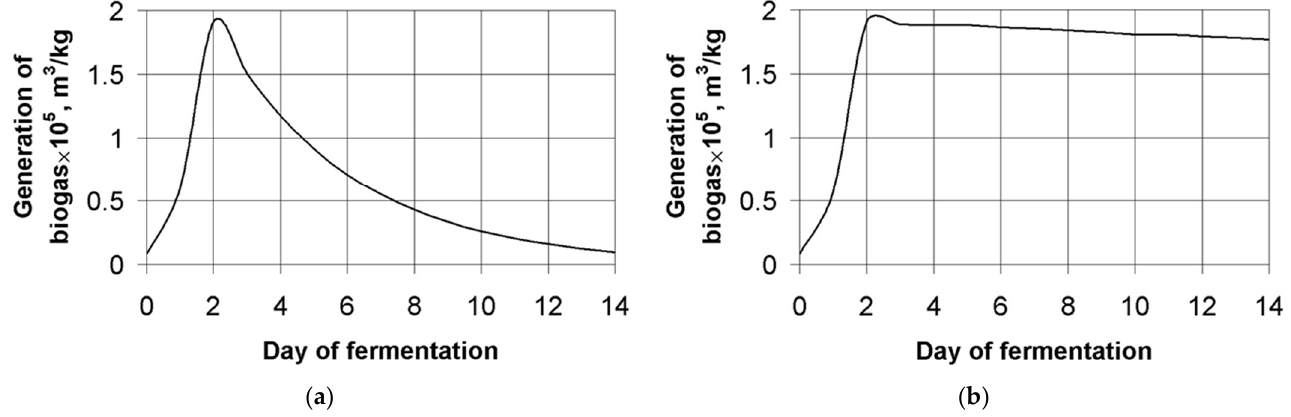
Figure 8. Dynamics of biogas output, obtained as a result of modelling the functioning of the me- thane tank of the biogas plant during the digestion of cattle manure with the addition of molasses: ( a )—for the periodic mode of loading of the methane tank; ( b )—for the quasi-continuous loading of methane tank.